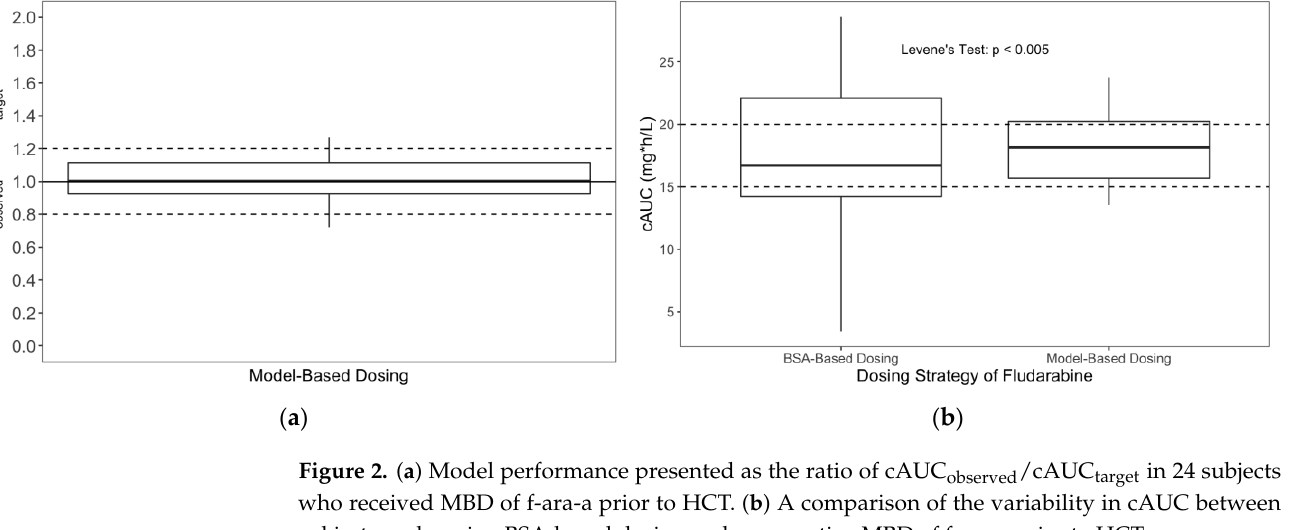
Figure 2. ( a ) Model performance presented as the ratio of cAUC observed /cAUC target in 24 subjects who received MBD of f-ara-a prior to HCT. ( b ) A comparison of the variability in cAUC between subjects undergoing BSA-based dosing and pre-emptive MBD of f-ara-a prior to HCT.